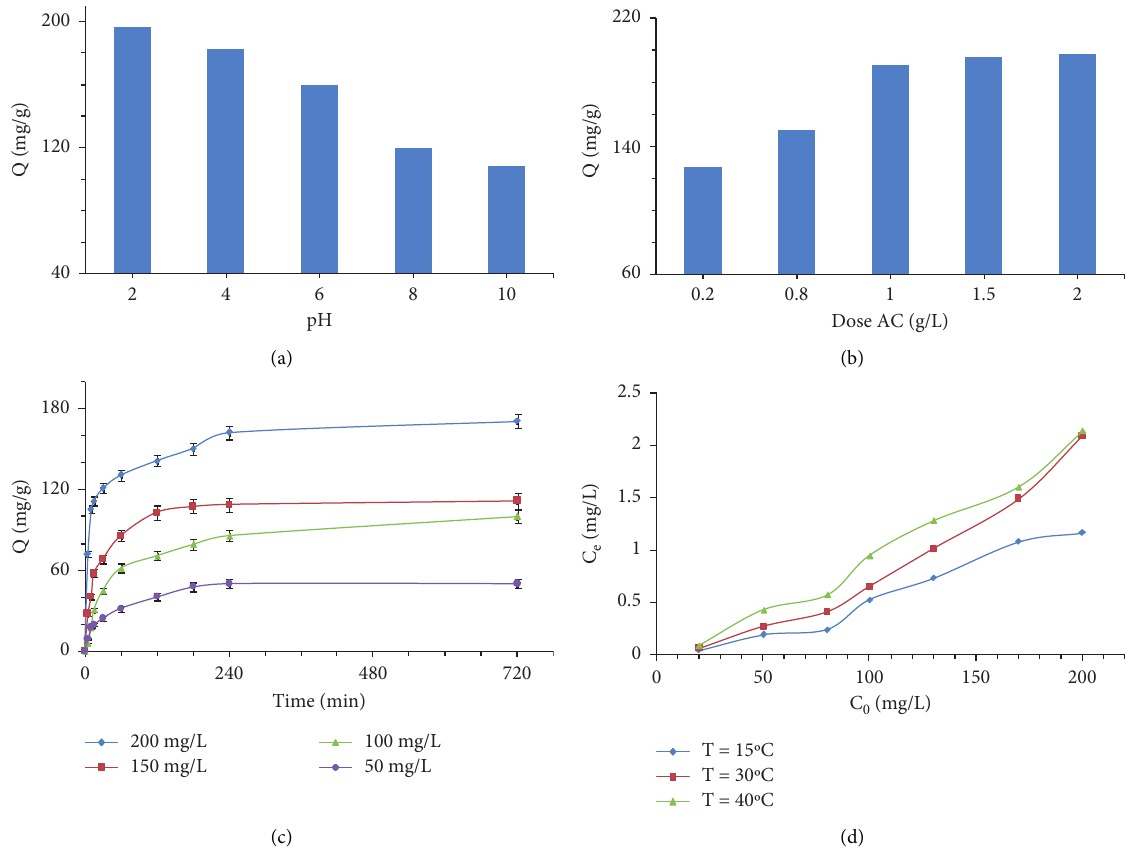
Figure 3: Effect of pH (a), adsorbent dose (b), contact time (c), and temperature (d) on the adsorption of